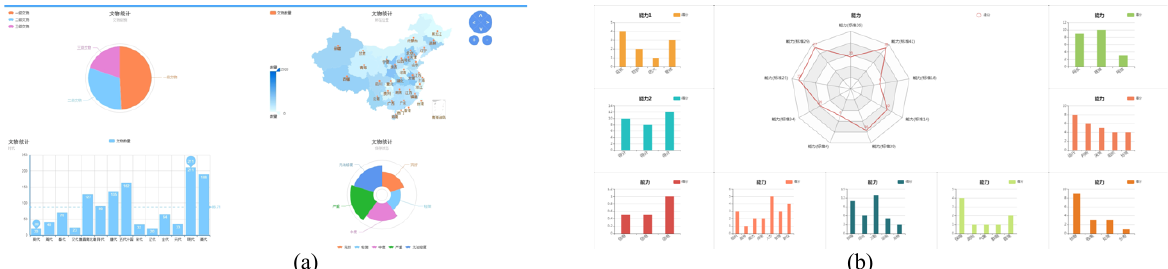
Figure 8. Sensor real-time monitoring of an overall statistics with indicators